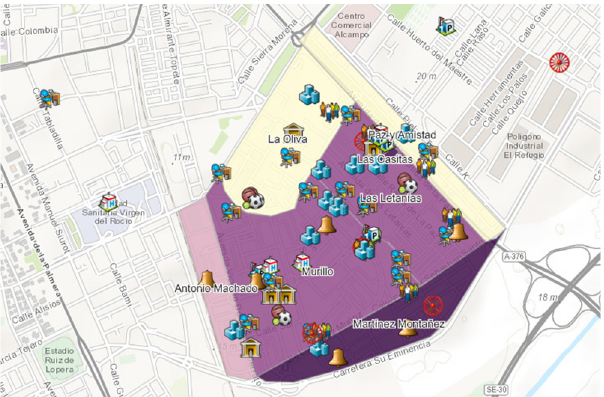
Figure 2. Screenshot of PS resources through a Roma sensitivity lens. This image shows density of Roma population (represented by darker shades) and identifies resources represented by type. For example, the bell icon represents faith-based organizations, blue centers represent educational services, and red circles represent Roma CBOs. This screenshot reveals that 80% of Roma live nearest two Evangelical churches and furthest away from formal health care services.